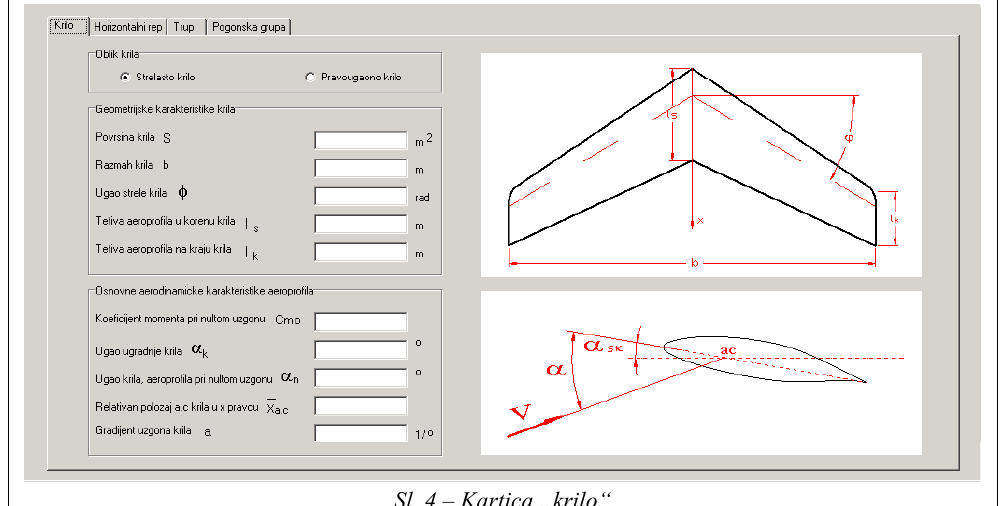
Doprinos krila stabilnosti u